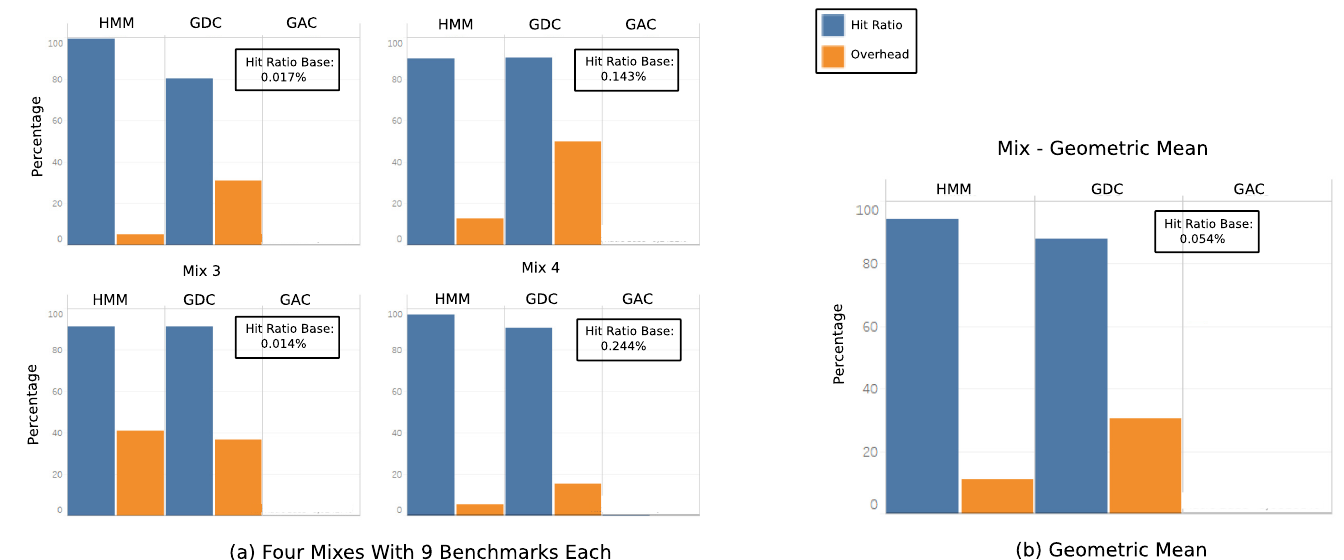
Fig 12. Hit ratio and overhead of BASE , HMM , G / DC and G / AC in a 9 core architecture. The hit ratio of the base experiment is shown in the box. Each mix consists of nine benchmarks.